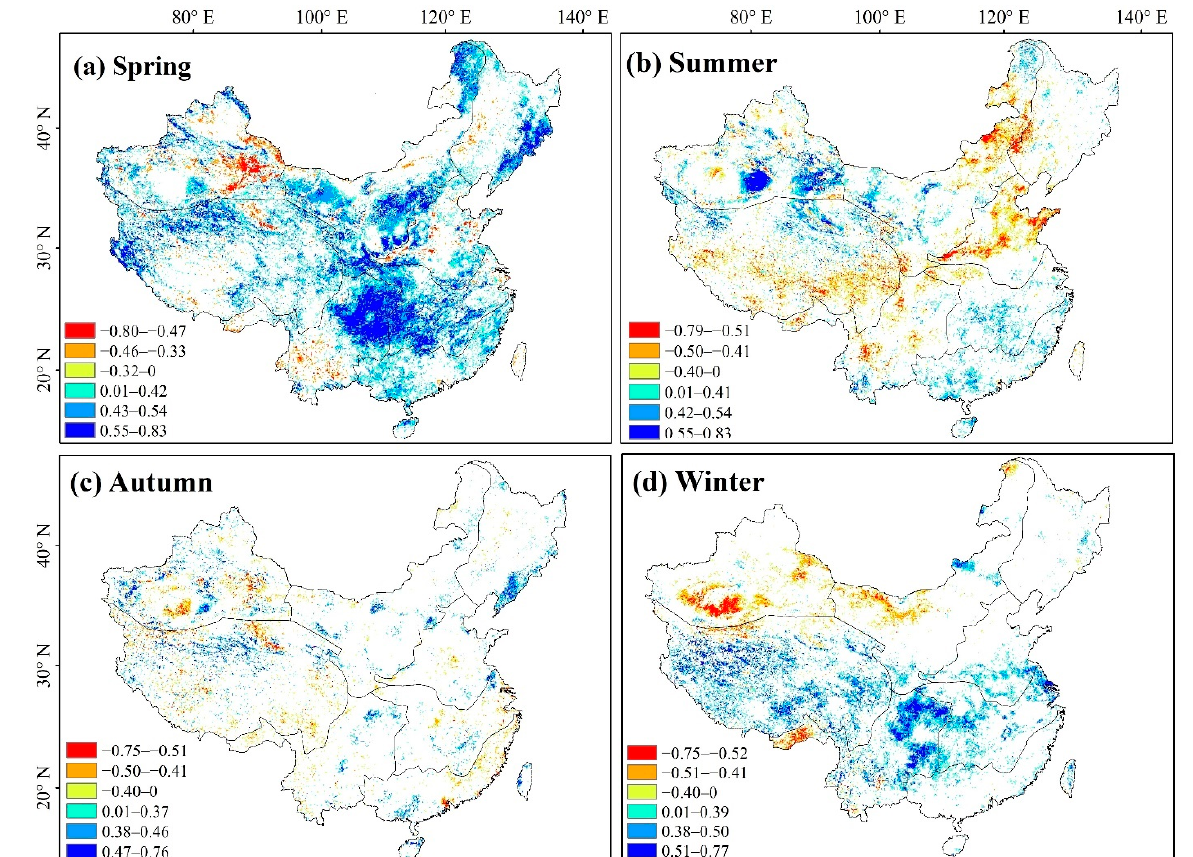
Figure 11. Seasonal correlation analyses ( α = 0.05) between vegetation and